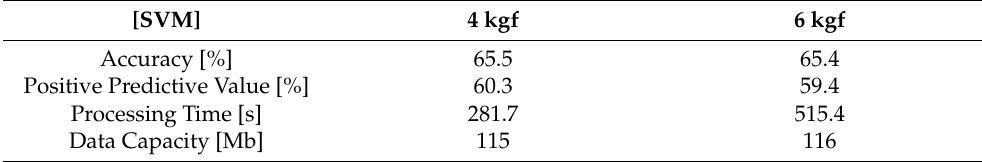
Table 17. Result of sensor data efficiency evaluation for optimal sensor selection of nip force non- uniformity fault.